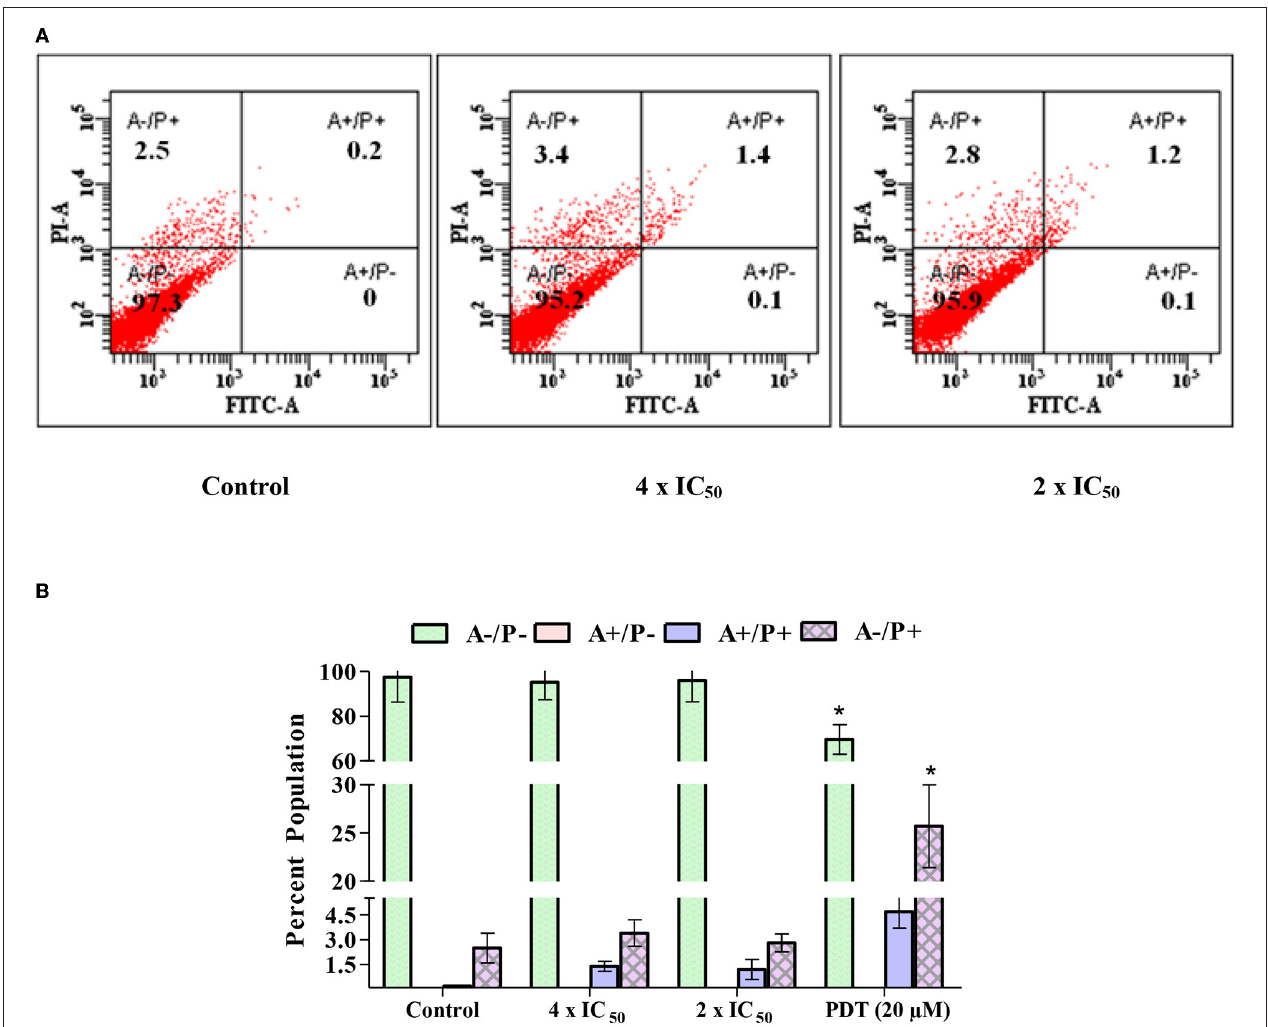
FIGURE 9 | (A,B) Carvacrol induces late apoptosis and necrosis of FaDu cells. FaDu cells were treated with carvacrol and stained with Annexin V-fluorescein isothiocyanate (FITC) and PI to determine apoptosis and necrosis through flow cytometer. The effect of carvacrol was non-significant and PDT was significant (* p <